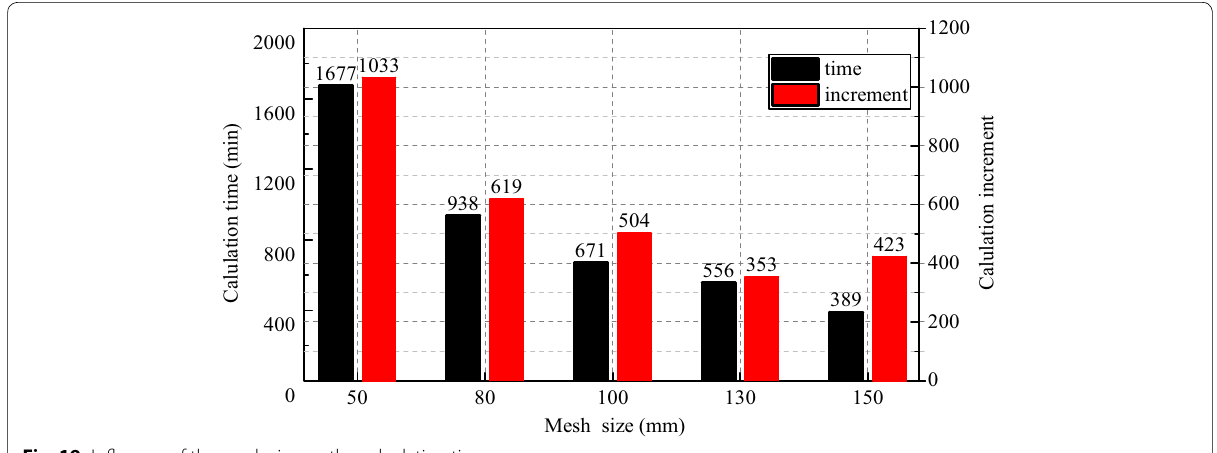
Fig. 19 Influence of the mesh size on the calculation time.